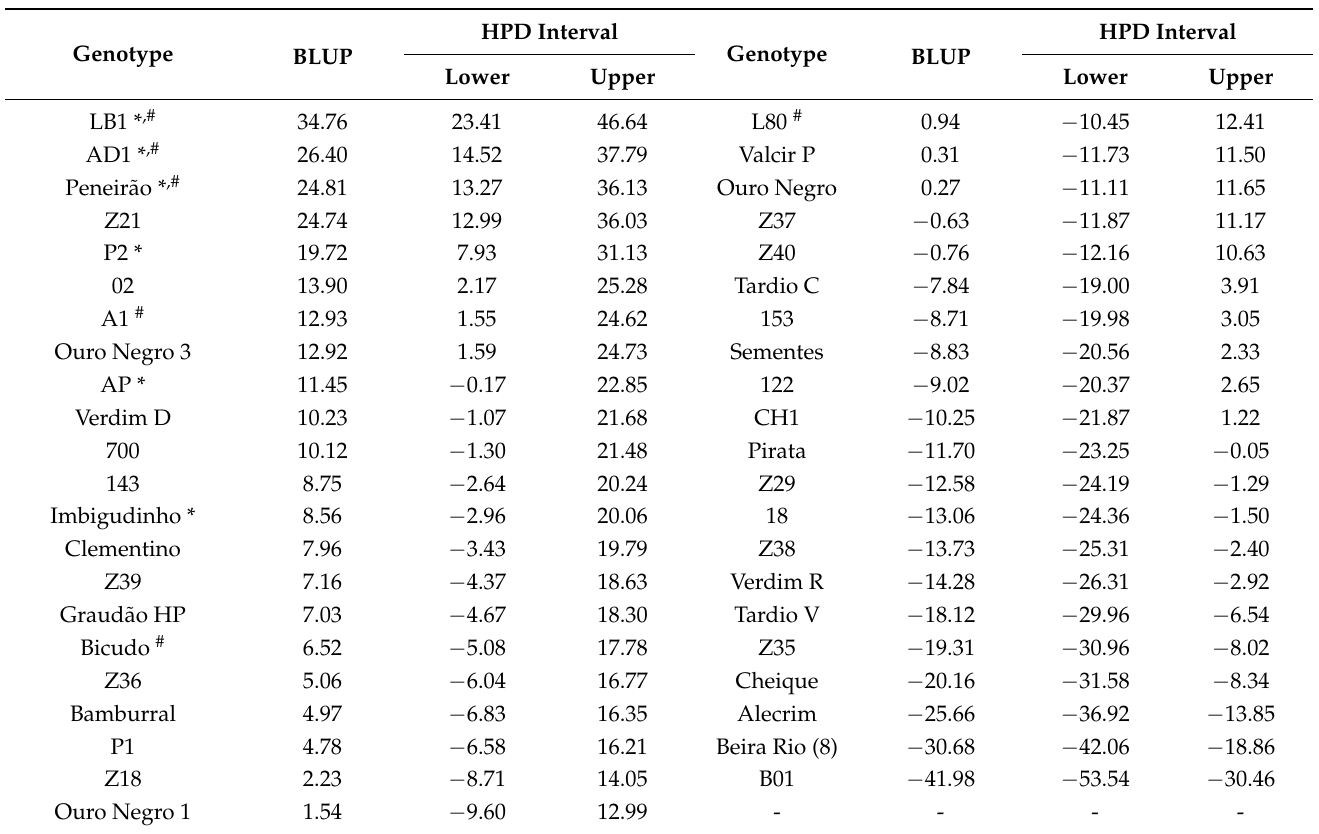
Table 2. The posterior mean of BLUP estimates for 43 coffee genotypes ( Coffea canephora ) and their higher posterior density (HPD) interval, estimates were obtained by a Bayesian